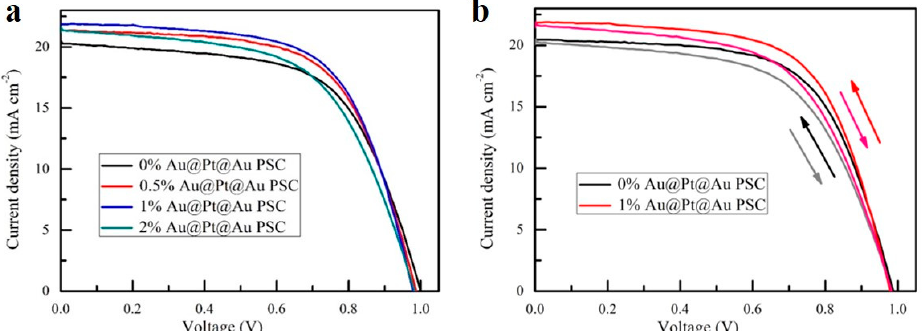
Figure 7. ( a ) J-V characteristics of cells incorporated with different amounts of Au@Pt@Au core-shell NPs under AM 1.5G irradiation (100 mW cm − 2 ); ( b ) J-V curves scanned from forward voltage to reverse voltage and scanned in the opposite direction. Table 1. Summarized photovoltaic parameters of different cells.